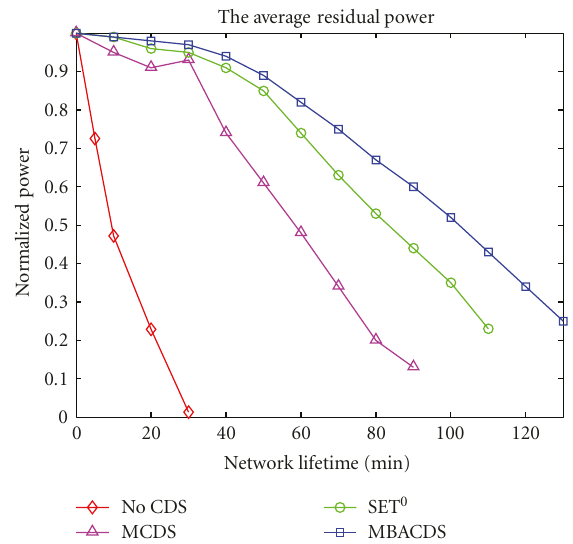
Figure 12: The average power per node in the